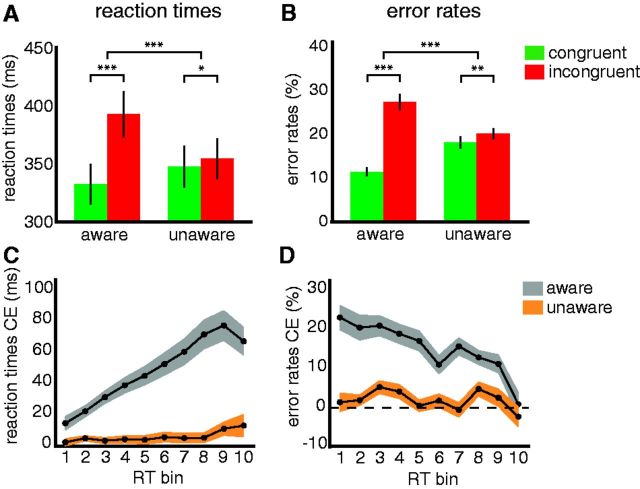
Results (A) Mean reaction times (in ms) in the unmasked (aware, left bars) and masked (unaware, right bars) conditions for visual motion stimuli that were preceded by a congruent (green) motion word were faster than when preceded by an incongruent (red) motion word. (B) Mean error rates (%) in the aware condition and unaware condition were lower for congruent than incongruent motion words. (C) The delta plot for reaction times (in ms) congruency effects (incongruent-congruent, CE) in the conscious (gray) condition showed the typical RT conflict-control profile with an initial CE increase over RT bins and a CE decrease in the last bin. In the unaware condition (orange), the CE was not affected by response time and did not decrease in the last bin. (D) Conditional accuracy functions for error rates (%) CE. Stronger response capture is associated with a higher percentage of fast errors. This pattern of decreasing CE across RT bins is present for the aware condition, but not for the unaware condition. Error bars denote SEM. *P < 0.05, **P < 0.01, ***P < 0.001.